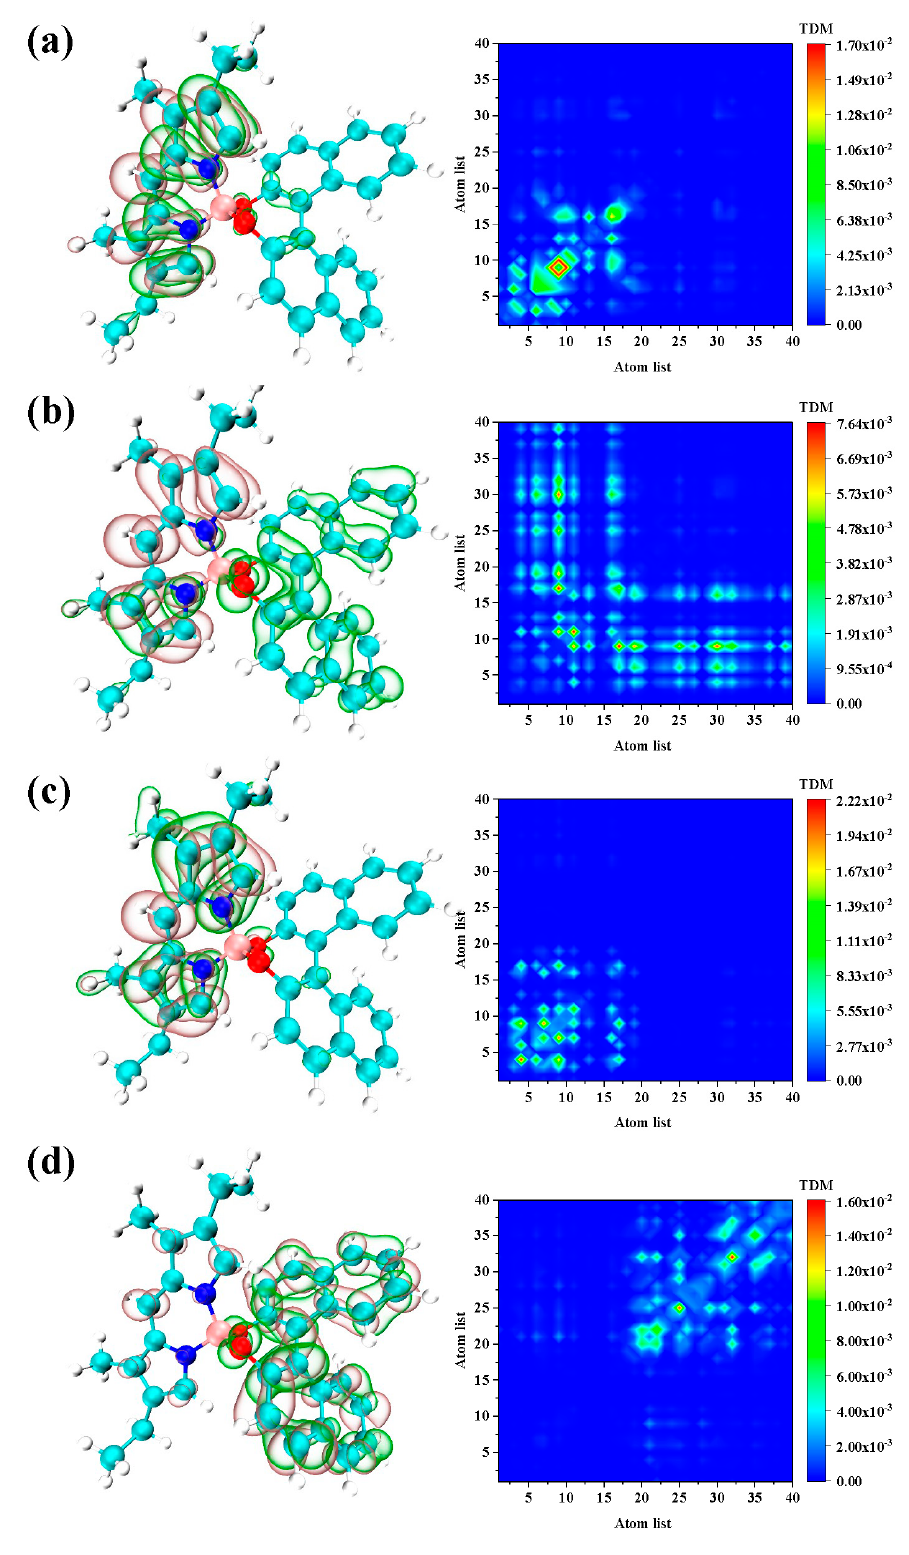
Figure 3. The electron-hole pair density (left) and transition density matrix (TDM) (right) of ( a ) S 1 , ( b ) S 3 , ( c ) S 4 , and ( d ) S 6 . The pink and green isosurfaces signify the electron and hole density,